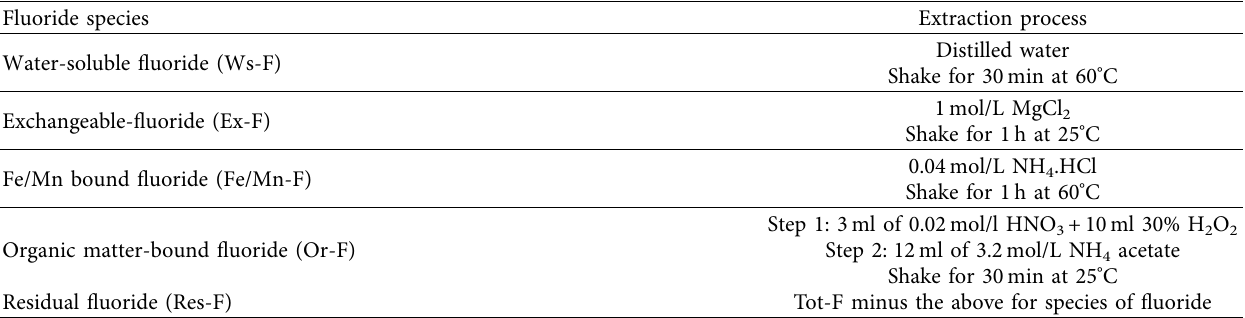
Table 1: Extraction processes of various fluoride fractions in the